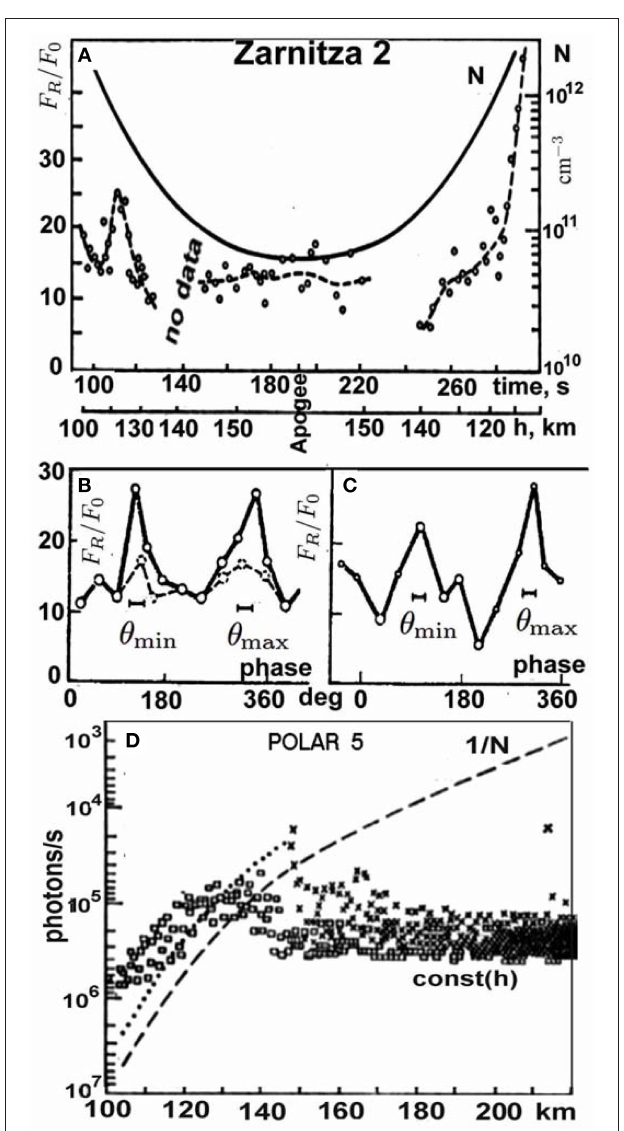
FIGURE 5 | (A) The radiation flux in the units of F 0 from the NRG in Zarnitza 2 averaged over 3–4 neighboring frames (circles). The dashed (solid) line shows the trend of F R (the neutral density, N , in cm − 3 ). (mid) Variation of the flux with the rocket spin phase for the intervals 150–290 s (the solid line) and 150–220 s (dashed) averaged over (B) 7 or 14 frames taken at 0.6 s from the start of ≤ long pulses and (C) 3 or 8 frames taken within 0.2 s. The phases for θ min and θ max are indicated. After Ivchenko et al. (1981). (D) The beam-induced luminescence in photon/s at λ 391.4 nm during Polar 5. The dashed line = shows 1 / N scaled. After Maehlum et al. (1980b) and Grandal (1982b). Reprinted by permission from Geomagnetism and Aeronomy and Plenum Press.